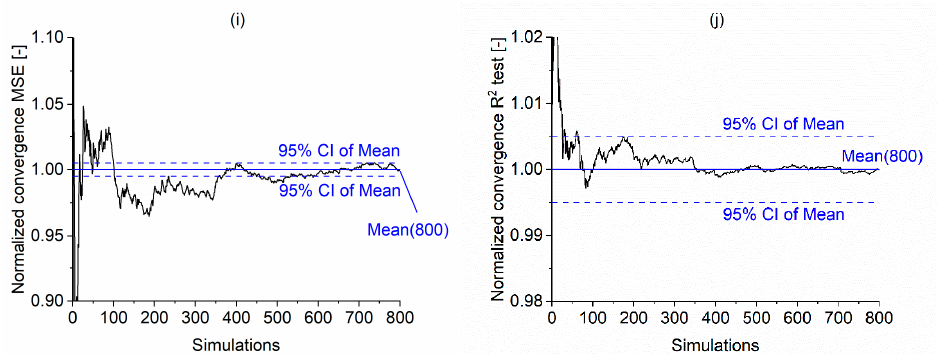
Figure 8. Comparison of the Monte Carlo normalized convergence of testing set MSE and R 2 for selected models: ( a , b ) ET1, ( c , d ) ET2, ( e , f ) ET3, ( g , h ) ET4, ( i , j ) ET5.